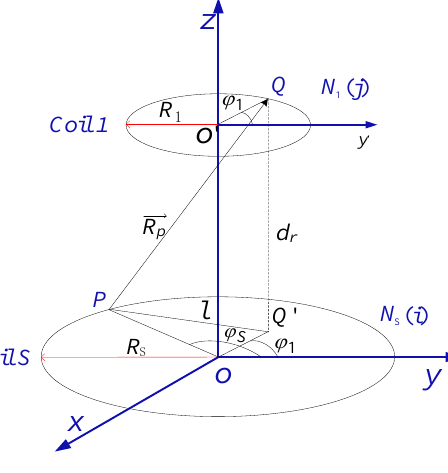
Figure 3. One loop model of perfectly aligned coils.